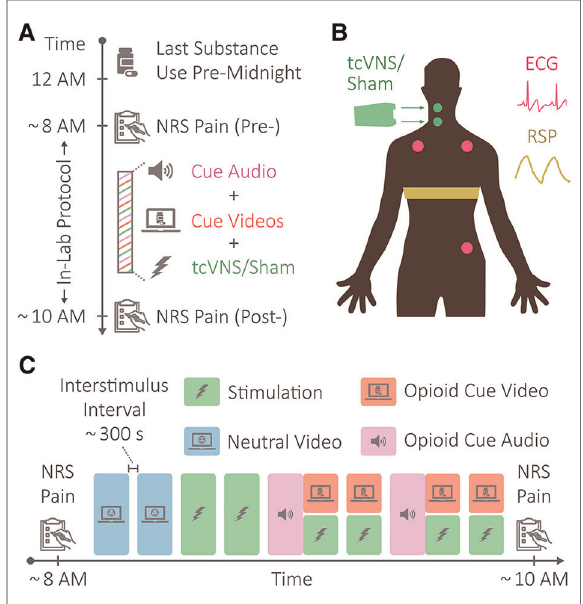
FIGURE 1 Protocol, stimulation, and physiological sensing. ( A ) Protocol overview. Patients with opioid use disorder (OUD) abstained from substance use for a minimum of eight hours prior to an in-lab protocol. The in-lab protocol consisted of opioid cue audio and videos meant to elicit opioid craving and active tcVNS or sham stimulation. ( B ) Physiological sensing and stimulation. The electrocardiogram (ECG) signal was sensed in a 3-lead con fi guration using Ag/AgCl electrodes placed as shown. Respiratory effort (RSP) was sensed using a resistive belt worn as shown. Transcutaneous cervical vagus nerve stimulation (tcVNS) or sham stimulation was delivered to the right side of the neck, targeting the carotid artery. ( C ) In-lab protocol. The in-lab protocol consisted of neutral videos, shown for control purposes, opioid cue audio and videos to elicit opioid craving, and tcVNS or sham stimulation. The protocol began and ended with pain measurements via the numerical rating scale for pain (NRS